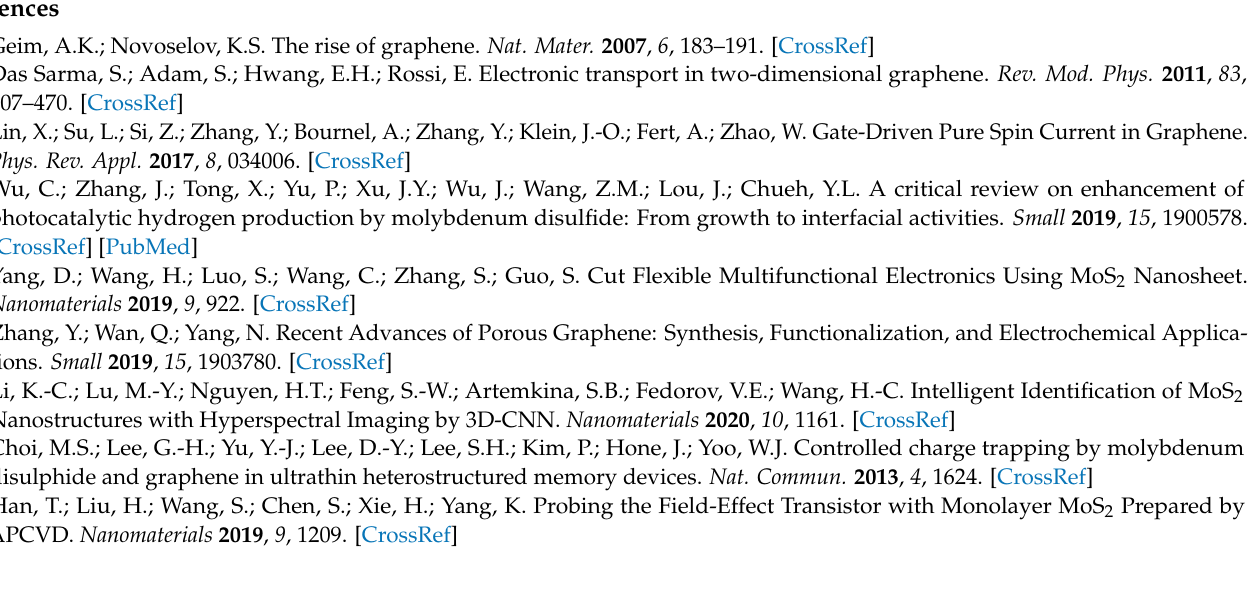
with periodically growing MoS 2 . (b) Partially enlarged image of (a). (c) Enlarged OM image of the red box in (b). Figure S2. (a) OM image of MoS 2 periodic growth. (b) SEM image of the cross-section of (a) marked by the red line, defined as Sample 1. (c) SEM image of the cross-section at Sample 2, where the red line marks the sampling defined as Sample 2 in (a). Figure S3. (a) A cross-sectional SEM image of Sample 1. (b) Schematic of the nomenclature of the section in (a). Figure S4. (a) Schematic of the cross-section of Sample 1. (b) HRTEM image of the red arrow in (a). (c) HRTEM image of the green arrow in (a). (d) HRTEM image of the blue arrow in (a). Figure S5. (a) Schematic of the cross-section of Sample 1. (b) HRTEM image of the red arrow in (a). (c) HRTEM image of the green arrow in (a). (d) HRTEM image of the blue arrow in (a). Figure S6. (a) Schematic of the cross-section of Sample 1. (b) HRTEM image of the red arrow in (a). (c) HRTEM image of the green arrow in (a). (d) HRTEM image of the blue arrow in (a). Figure S7. (a) Schematic of the cross-section of Sample 1. (b) HRTEM image of the red arrow in (a). (c) HRTEM image of the green arrow in (a). (d) HRTEM image of the blue arrow in (a). Figure S8. (a) Schematic of the cross-section of Sample 1. (b) HRTEM image of the red arrow in (a). (c) HRTEM image of the blue arrow in (a). Figure S9. (a) TEM image of the cross-section of the substrate without periodic MoS 2 holes. (b) TEM image of the cross-section of the substrate with MoS 2 periodic holes. Figure S10. (a) HRTEM image of the cross-section of the substrate with periodic holes in MoS 2 . The boxed area is where EDS analysis was performed. (b)